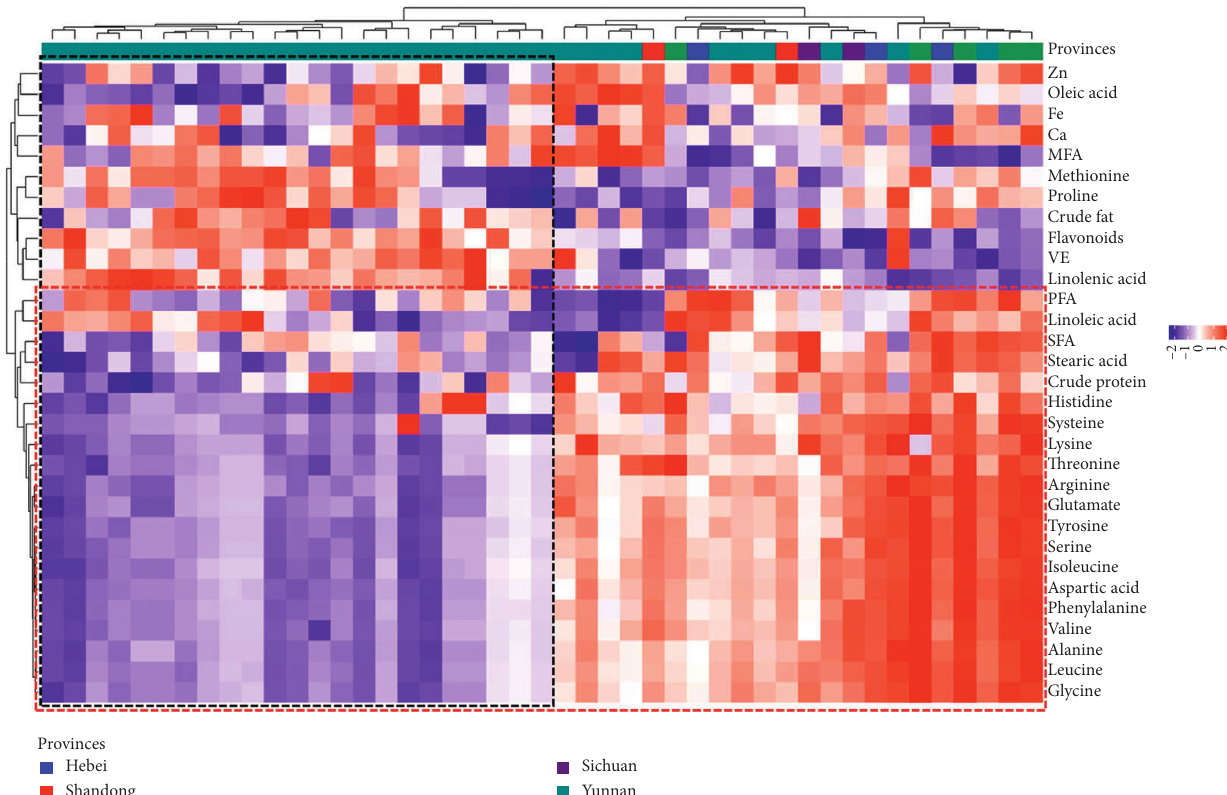
Figure 8: The heat map of the main physical and chemical factors in 45 different types of walnuts from the main five walnut-planting provinces in